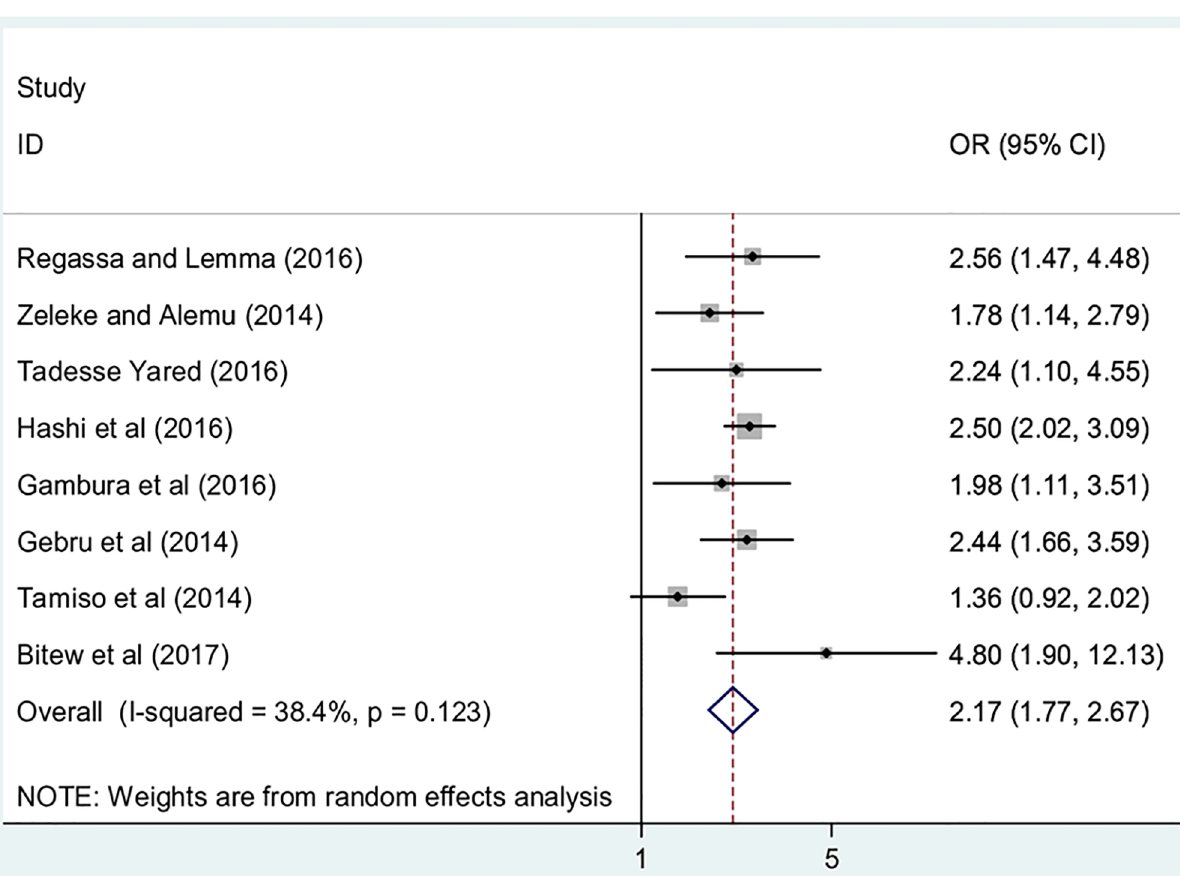
Fig 7. The pooled odds ratio of the association between maternal hand washing practices and childhood diarrhea in Ethiopia.